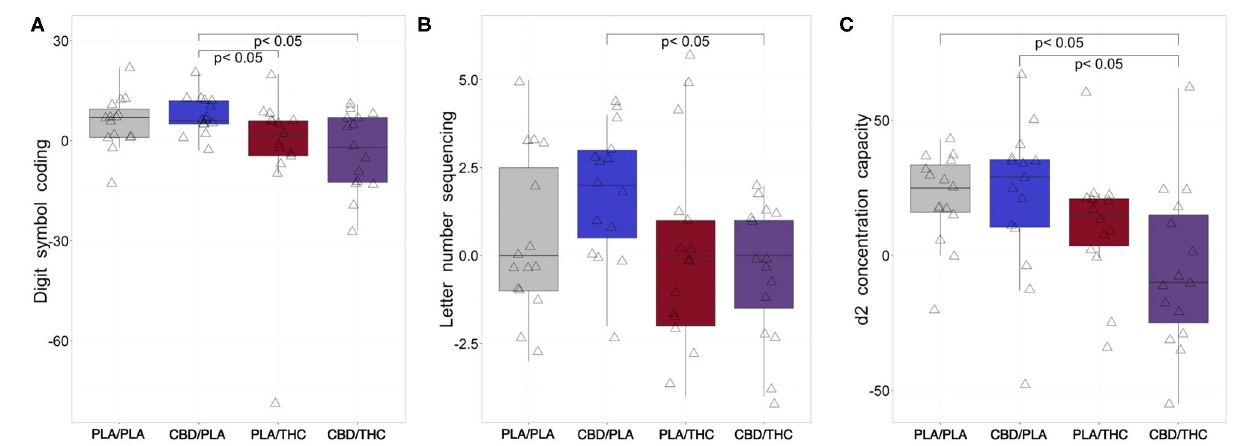
FIGURE 3 | Changes of cognition from baseline to investigational assessment. (A) While subjects treated with placebo (PLA) prior to placebo (PLA/PLA) and 800mg cannabidiol orally (CBD) prior to placebo (CBD/PLA) improved their cognitive processing at the interventional day compared to baseline (reflected by positive difference scores in the Digit Symbol Coding task), subjects receiving 20mg of delta-9-tetrahydrocannabinol orally (THC) proceeded by placebo (PLA/THC) or CBD (CBD/THC) showed a slightly reduced performance. The difference scores of both PLA/THC and CBD/THC) was significantly lower compared to the CBD/PLA group (PLA/THC: p = 0.039; CBD/THC: p = 0.016). (B) After CBD/PLA, the change in working memory performance (from baseline to 205min post drug intake) assessed by the Letter Number Sequencing task seemed to be most pronounced. Interestingly the difference score observed for CBD/PLA was significantly higher than the score of the CBD/THC group ( p = 0.005). (C) At the interventional day, we observed higher mean attentional d2 scores compared to baseline after PLA/PLA, CBD/PLA, and PLA/THC treatment. In subjects who received CBD/THC, an increased attentional performance was not observed, and the difference score was significantly lower compared to the PLA/PLA ( p = 0.005) and CBD/THC ( p = 0.010) group. PLA/PLA, placebo/placebo; CBD/PLA, cannabidiol/placebo; THC/PLA, delta-9-tetrahydrocannabinol/placebo; CBD/THC, cannabidiol/